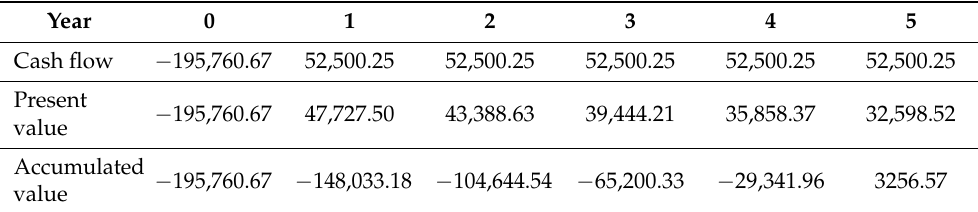
Table 9. Annual cash flow for crude palm oil ( Elaeis guineensis , Jacq) and discounted payback analysis, profitability index, internal rate of return (IRR) and net present value (NPV)